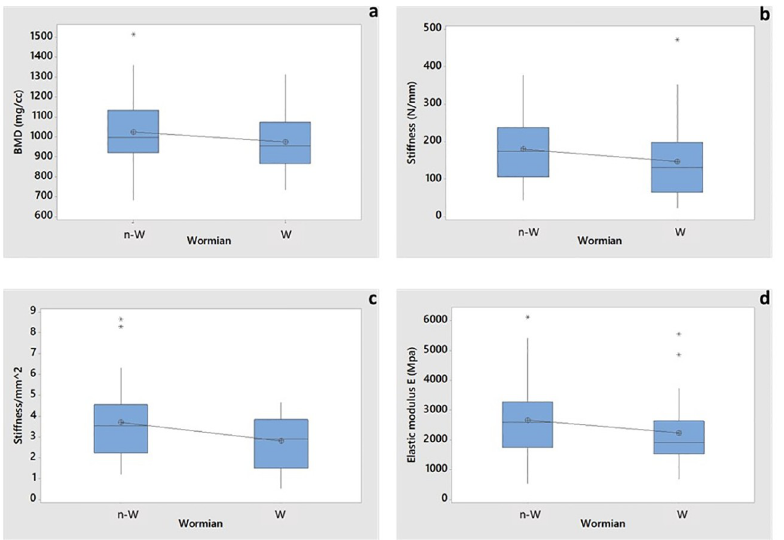
Fig 8. Boxplot of 2-sample t-test for assessing the influence of Wormian bone on. a) BMD (p-value 0.252), b) Stiffness S (p-value 0.221), c) Stiffness normalized with respect to the cross-sectional area (p-value 0.038) and d) Young’s moduli E (p-value 0.198). Asterisks represent the outliers. N-W indicates no-Wormian samples, W indicates Wormian samples.